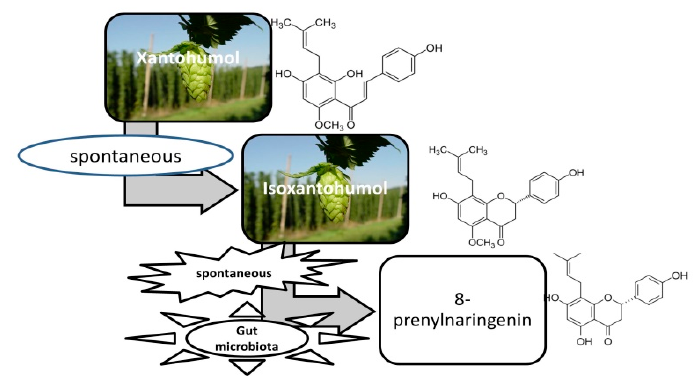
Figure 2. Transformation of xantohumol in the digestive system.